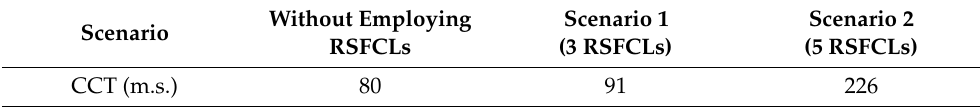
Table 4. CCT improvement in the investigated